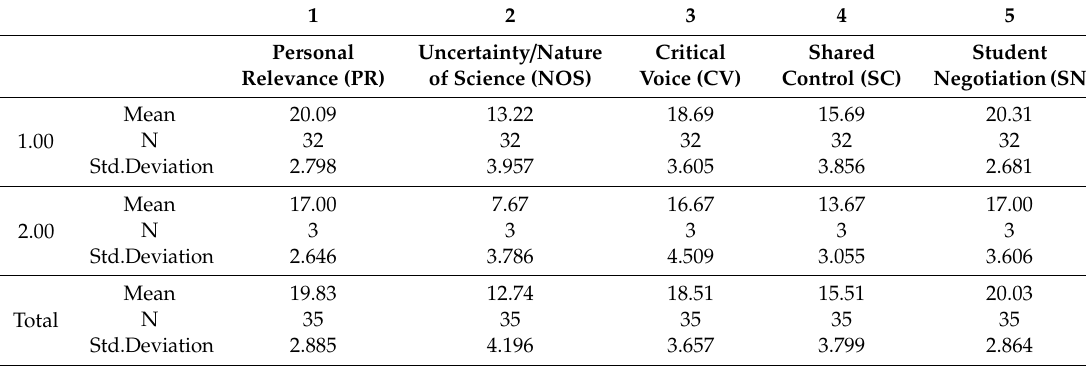
Table 2. High (2) and low (1) relativism and aspects of